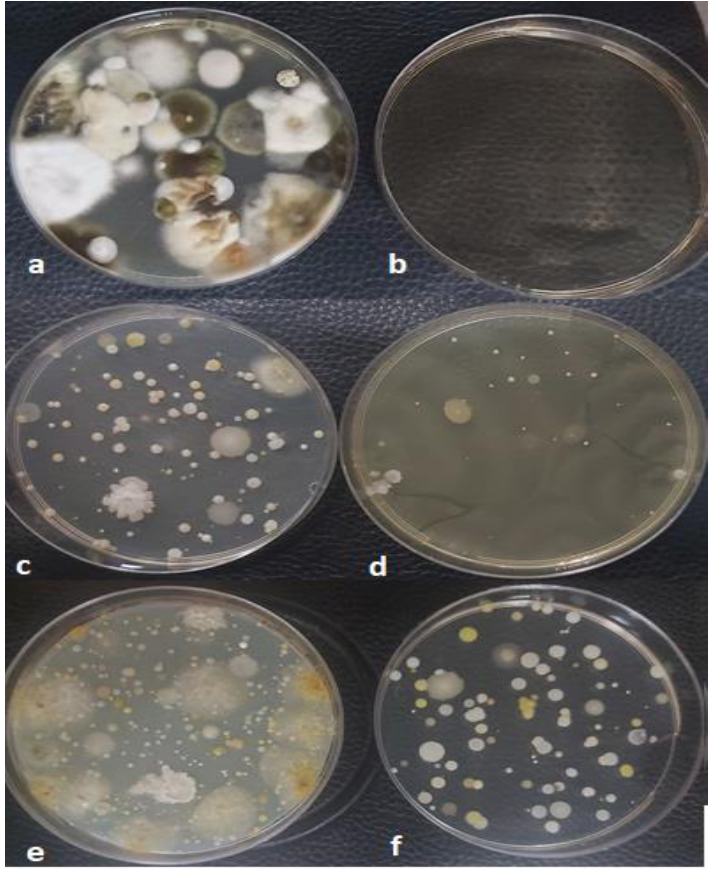
Figure 6. Selected samples collected with open settling plates. Passive sampling of fungi close to outdoor areas with settling plate for ( a ) 4 h and ( b ) 8 h settling periods, 7 days incubation. Passive sampling of bacteria with settling plate at office desk for ( c ) 4 h and ( d ) 8 h. Passive sampling of bacteria with settling plate at table of main hall, ( e ) 4 h and ( f ) 8 h sampling periods.